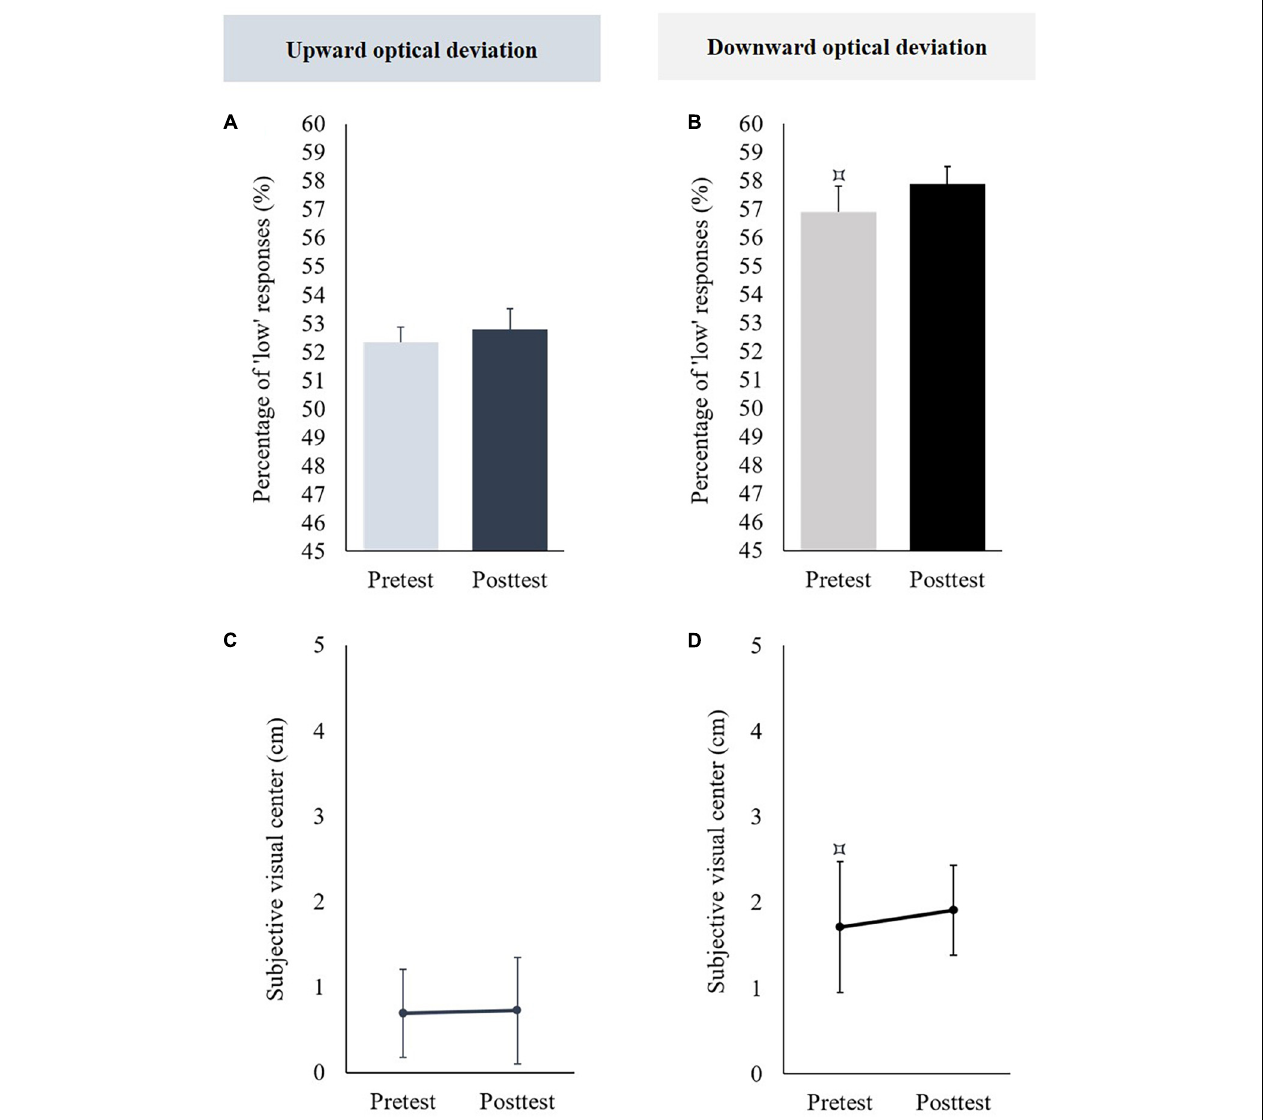
FIGURE 3 | Aftereffects of vertical prism adaptation on visuospatial representation. Data obtained in the group using an upward optical deviation are represented in the left part; data obtained in the group using a downward prism adaptation are represented in the right part. Panels (A,B) display the percentage of “low” responses before (pretest) and after (posttest) vertical prism adaptation; panels (C,D) display the subjective visual center before (pretest) and after (posttest) vertical prism adaptation. The pretest was compared to 50 [for the percentage of “low” responses, panels (A,B) ] or 0 [i.e., objective visual center, panels (C,D) ]: